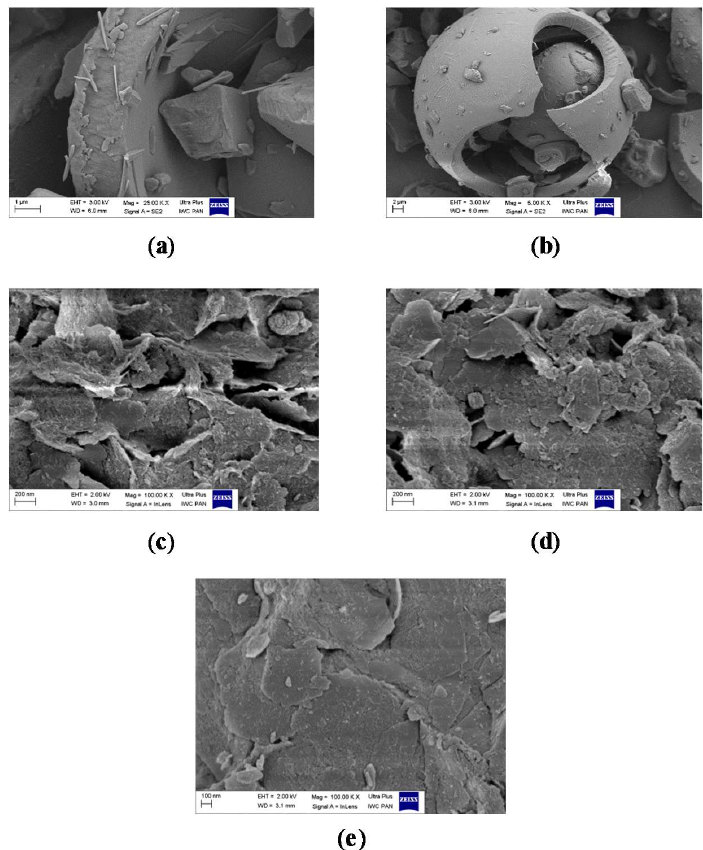
Figure 11. SEM morphology of: ( a , b ) carminic acid; ( c ) LH/CA (10%); ( d ) LH/CA (20%); ( e ) LH.